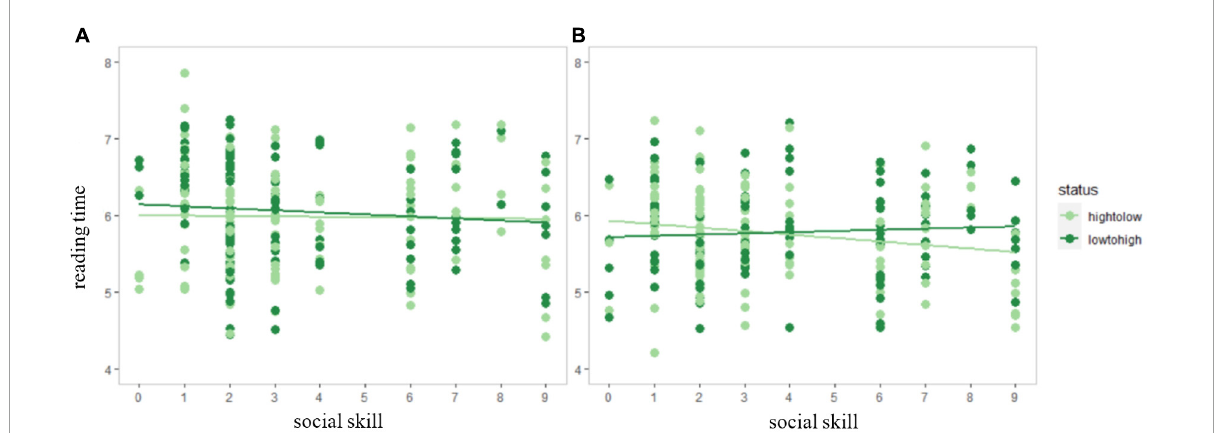
FIGURE2 Social skill and logarithmic total reading time of irony in the first (A) and the second half (B) of the experiment in critical region. The plots represent the data point for each condition (light green: high-to-low, dark green: low-to-high). The light and dark green lines are the regression lines of irony with high-to-low and low-to-high conditions,